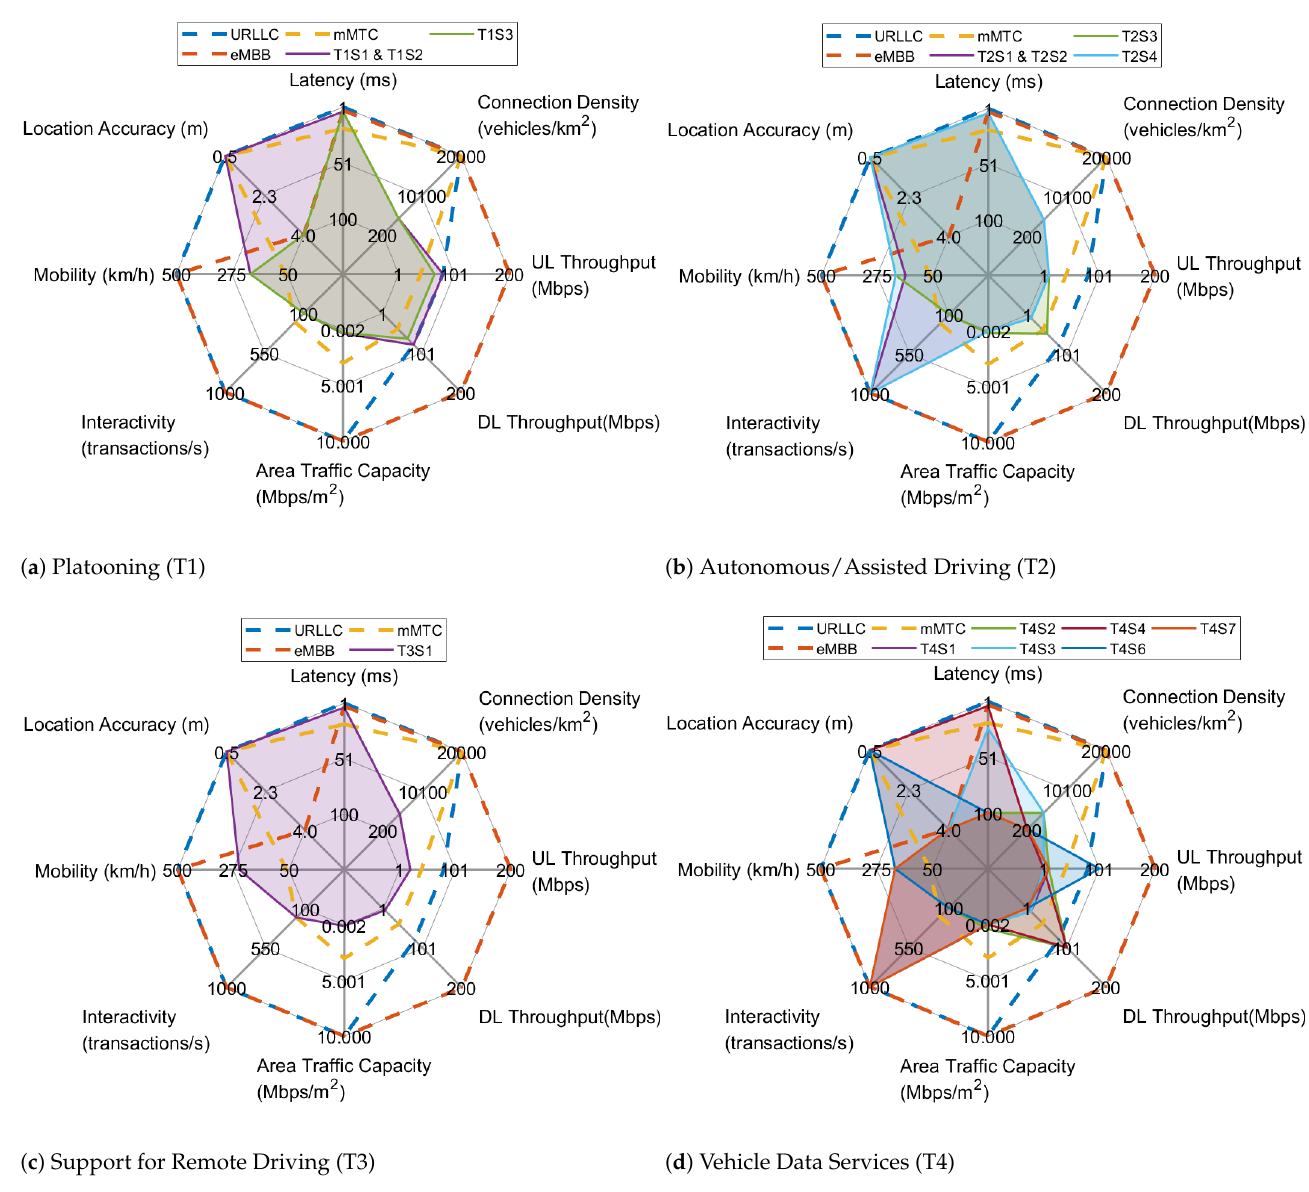
Figure 4. KPIs of Transport use cases and respective